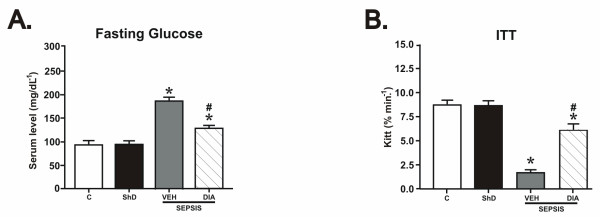
Fasting blood glucose (A) and glucose disappearance rate (B). Data are presented as mean and SD of six to eight rats per group. *P < 0.05 versus Sham/Vehicle; #P < 0.05 (Sepsis/Veh versus Sepsis/Dia). C, Sham/Vehicle; ShD, Sham/Diacerhein; VEH, Sepsis/Vehicle; DIA, Sepsis/Diacerhein.